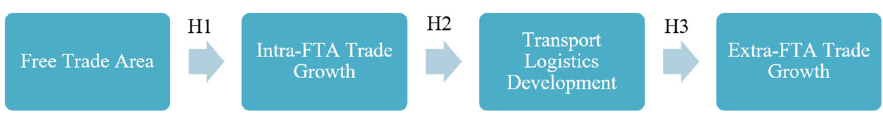
Fig. 1 Intra-FTA trade, Transport Logistics Development, and Extra-FTA trade: A Chain